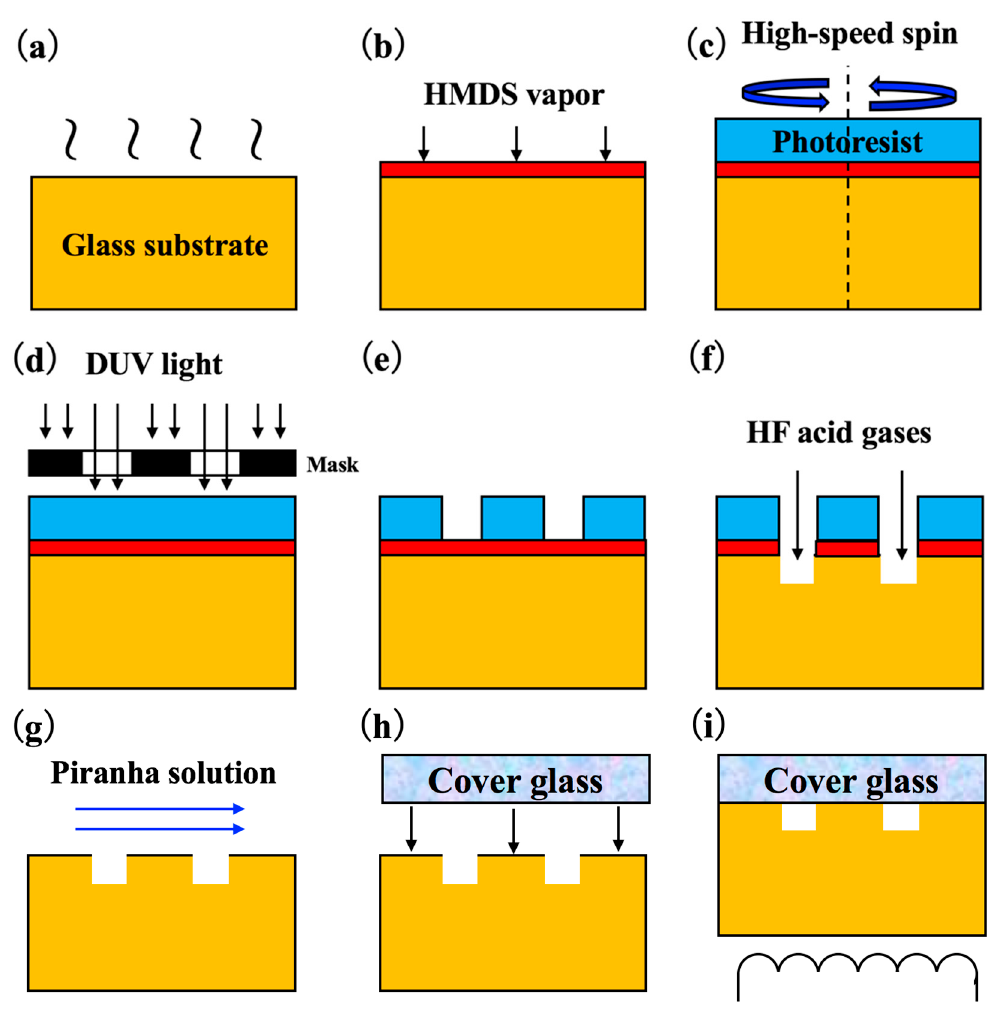
Figure 5. Visual micromodel fabrication process: ( a ) pretreatment (pre-baking and cleaning); ( b ) priming HMDS; ( c ) photoresist spin coating; ( d ) DUV exposure; ( e ) developing; ( f ) etching by HF acid gases; ( g ) cleaning by piranha solution; ( h ) bounding; and ( i ) heating.